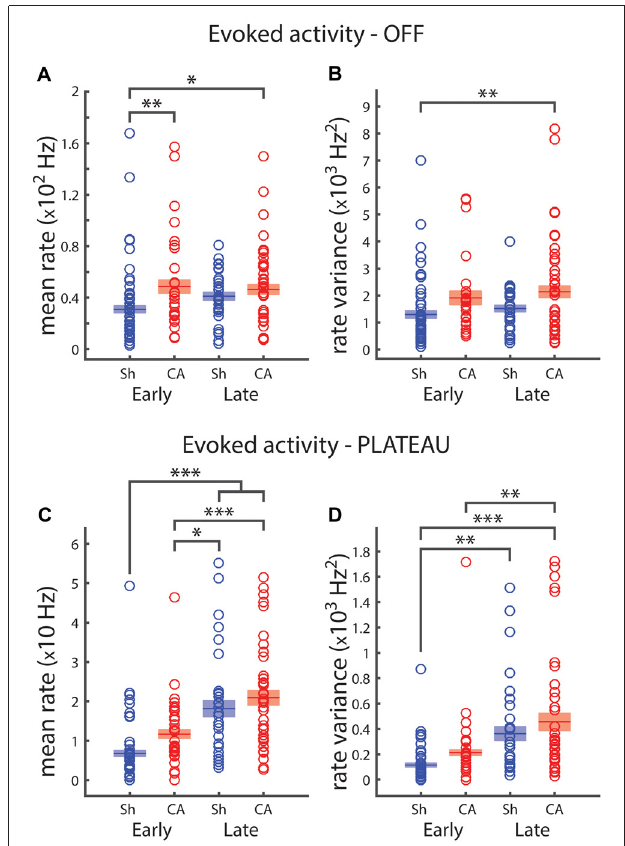
FIGURE 2 | Plateau and OFF responses depend on development and are affected by ischemic injury. (A) Early sham average OFF response rate is significantly lower that both CA groups. (B) Firing rate variance of OFF whisker responses reveals that early sham response is less variable that late CA response. (C) Firing rates for the 125 ms plateau period preceding whisker offset. Early sham rate is smaller than both late group rates; early CA rate is smaller than both late group rates. (D) Early sham plateau responses are less variable than both late group responses; early CA firing rate variance is smaller than late CA firing rate variance. Horizontal bars and rectangular shaded regions indicate mean ± S.E.M. of the α -trimmed data sets. ∗ Indicates p < 0.05, ∗∗ indicates p < 0.01 and ∗∗∗ indicates p < 0.001.